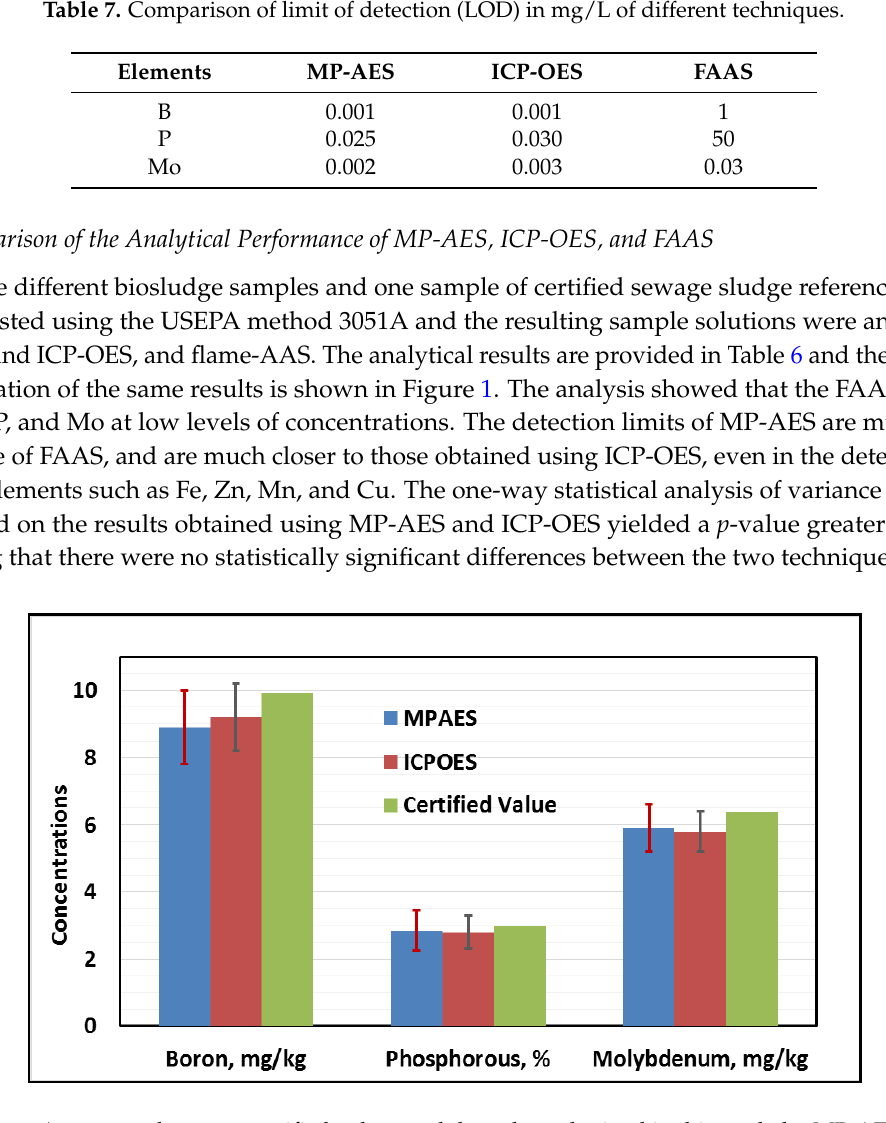
Figure 1. Agreement between certified values and the values obtained in this study by MP-AES and ICP-OES for B, P and Mo in SRM-Sewage Sludge EnviroMAT (BE-1).